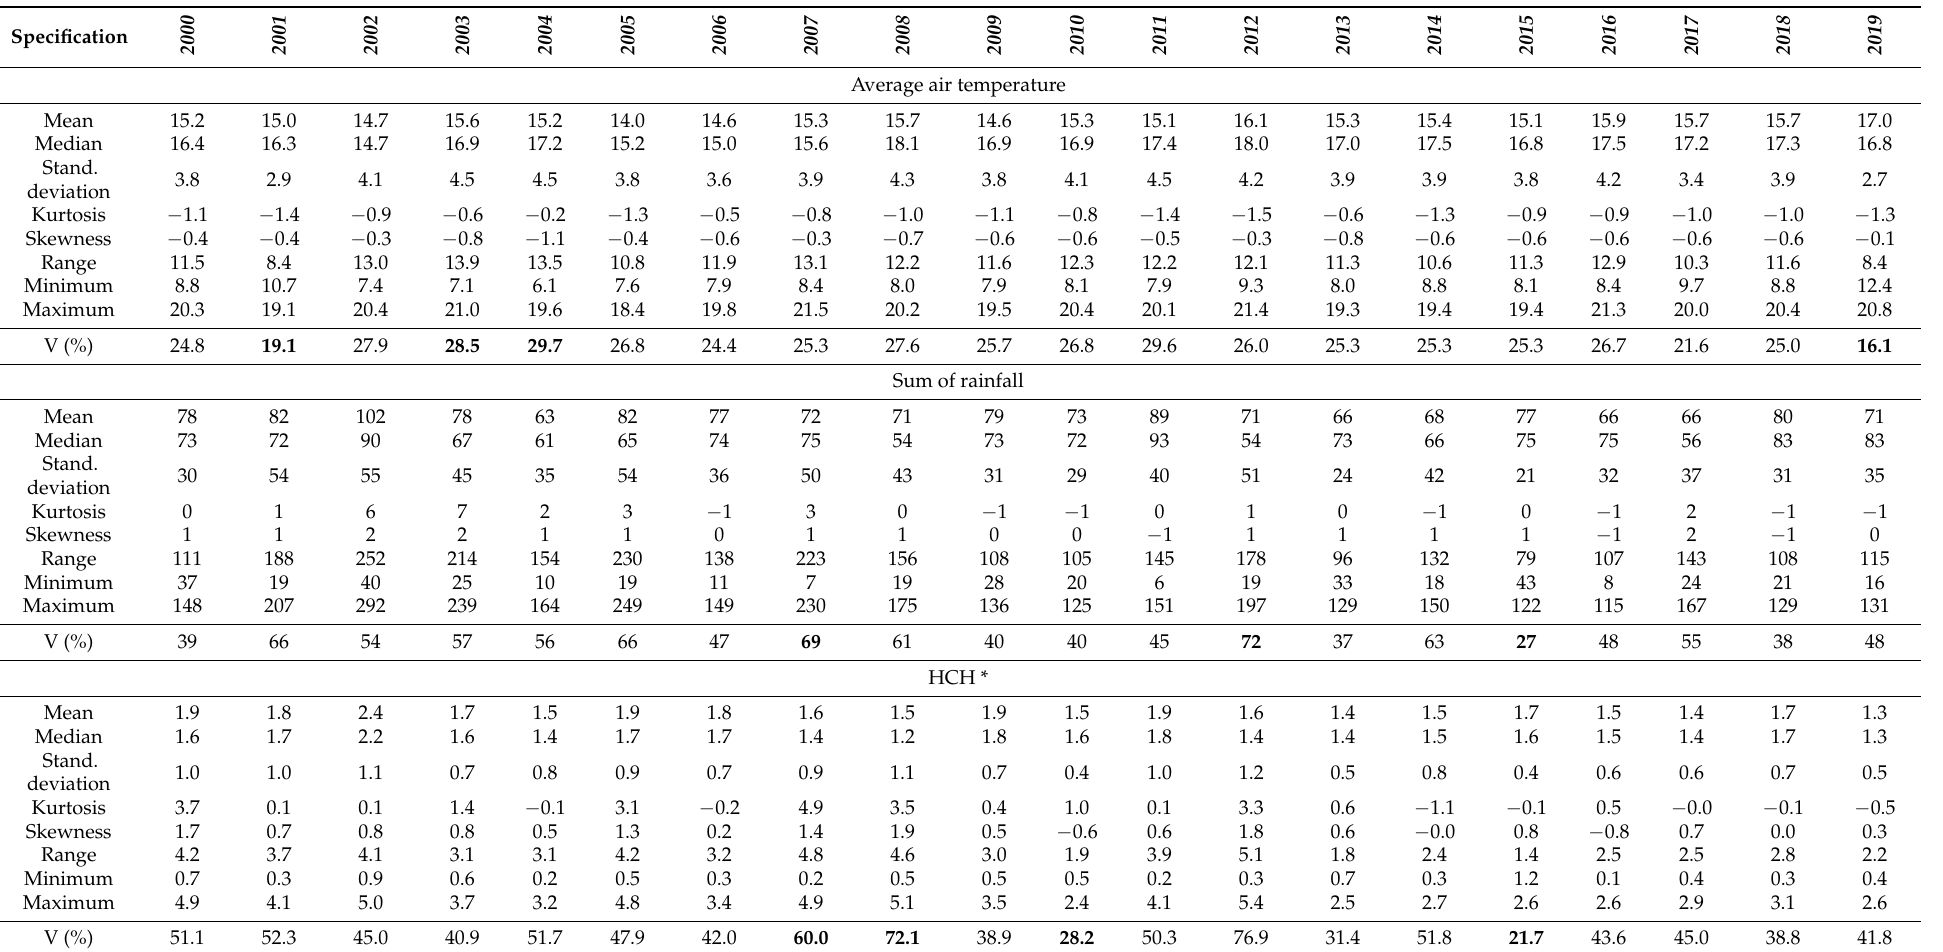
Table 1. Descriptive statistics of average air temperature, precipitation totals and the hydrothermal coefficient of Sielianinov in 2000–2019 according to COBORU meteorological stations in Dukla, Nowy Lubliniec Przecław and Skołosz ó w for the potato vegetation period